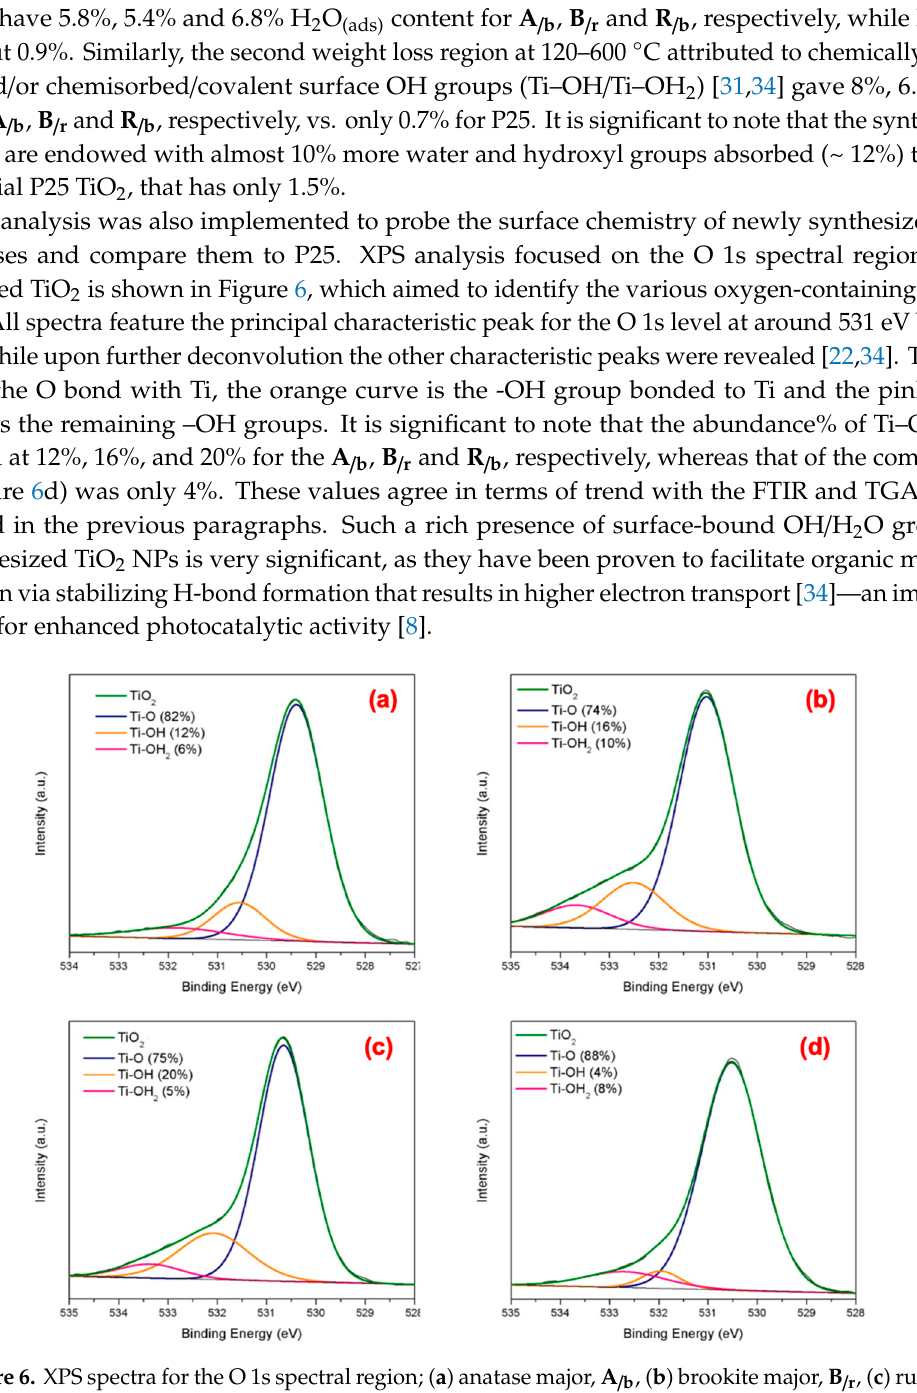
Figure 6. XPS spectra for the O 1s spectral region; ( a ) anatase major, A /b , ( b ) brookite major, B /r , ( c ) major, R / b , and ( d ) commercial rutile major, R /b , and ( d ) commercial P25.